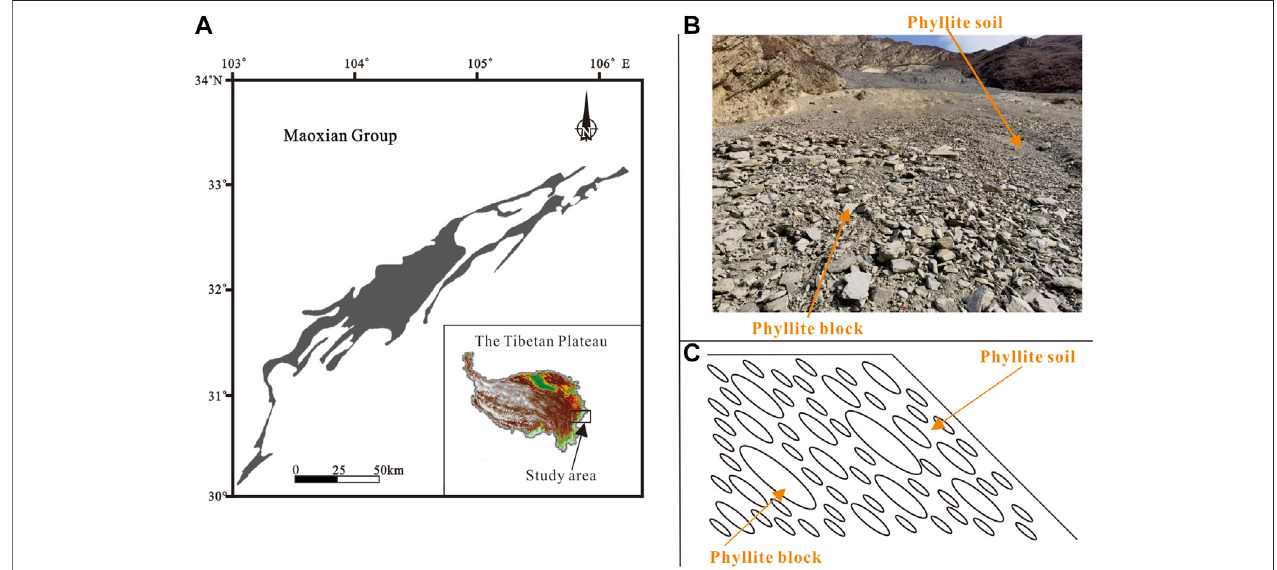
FIGURE1| Phyllitebimrocksdistributionandorientationofblocksinphyllitebimrocks. (A) Thedistributionofphyllite(MaoxianGroup,Silurian)attheeasternmargin of the Tibetan Plateau; (B) Structure of phyllite bimrocks, which is composed of phyllite blocks and phyllite soil; (C) Schematic diagram of the orientation of blocks in phyllite bimrocks (the phyllite blocks generate a similar imbricate texture in phyllite